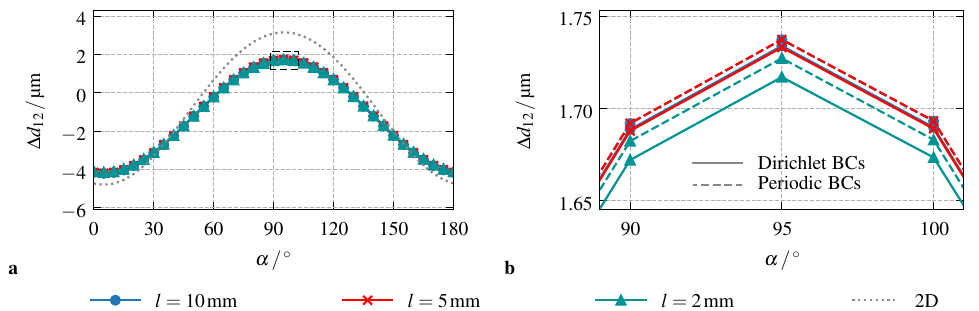
Figure 2. Study on the influence of the sample size. Results obtained using the finite element method for different length parameters l : ( a ) Dirichlet BCs according to the setup described in Section 2, and, ( b ) comparison of the results obtained for Dirichlet and periodic BCs close to the peak of ∆ d 12 . The dotted gray lines in ( a ) represent the results for the simplified two-dimensional